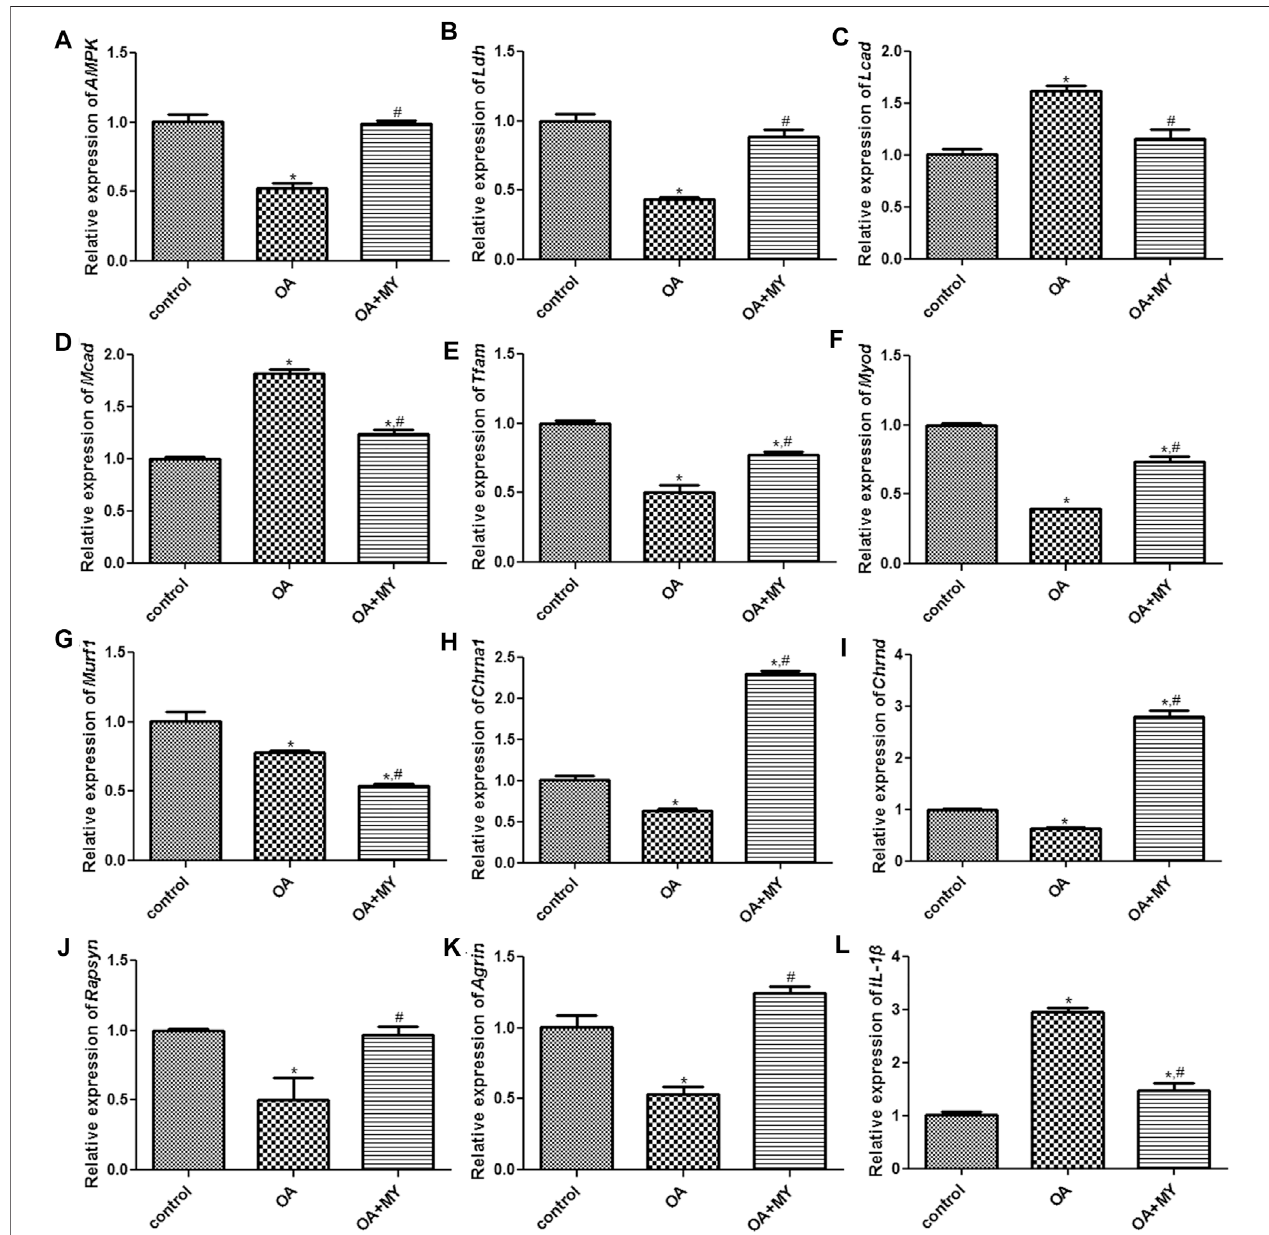
FIGURE 6| Effects of MY on the expressions ofrelated genes in the tibia muscle of different groups. mRNA expression of AMPK (A) , Ldh (B) , Lcad (C) , Mcad (D) , Tfam (E) , Myod (F) , Murf1 (G) , Chrna1 (H) , Chrnd (I) , Rapsyn (J) , Agrin (K) , and IL-1 β (L) . * p < 0.05, compared with the control group; # p < 0.05, compared with the OA